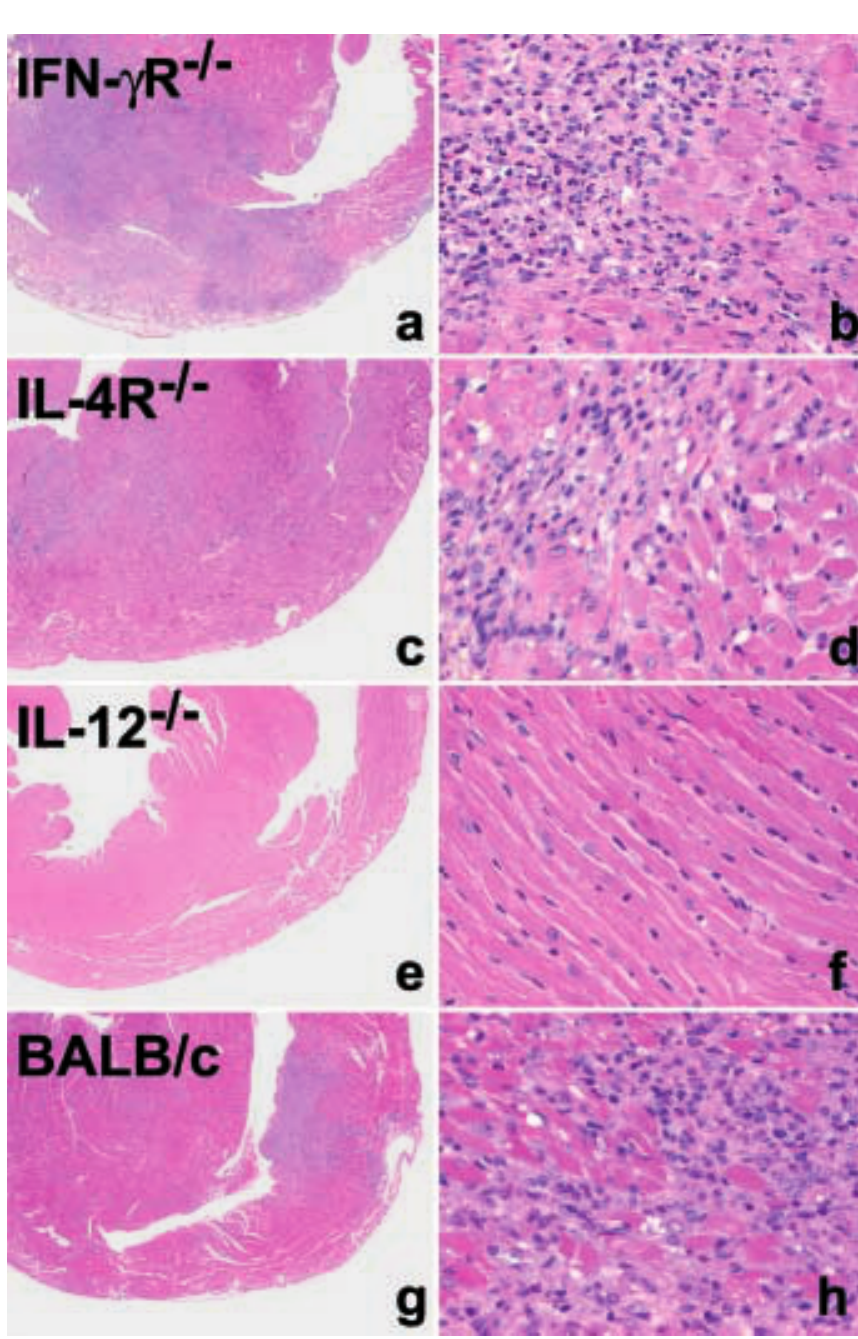
Fatal myocarditis 4 weeks after onset of flu-like symptoms in a 47-year-old previously healthy female. The macrophotograph of the right ven- tricular wall shows patches of white-looking inflammatory infiltrates. The low power mi- crophotograph shows a dense inflammatory infiltrate essentially sparing the epicardial adi- pose tissue. The high power microphotograph shows inflammatory cells infiltrating between and replacing cardiomyocytes. The inflamma- tory infiltrate contains numerous eosinophils in this example of eosinophilic myocarditis, which is reminiscent of the myocarditis ob- served in interferon- g receptor knock-out mice. Eosinophilic myocarditis is seen in about 5% of endomyocardial biopsies with myocarditis, and represents a distinct form of myocarditis addi- tional to lymphocytic and giant cell myocarditis (haematoxillin-eosin staining, original magnifi- cations 30 (cid:2) and 400 (cid:2)